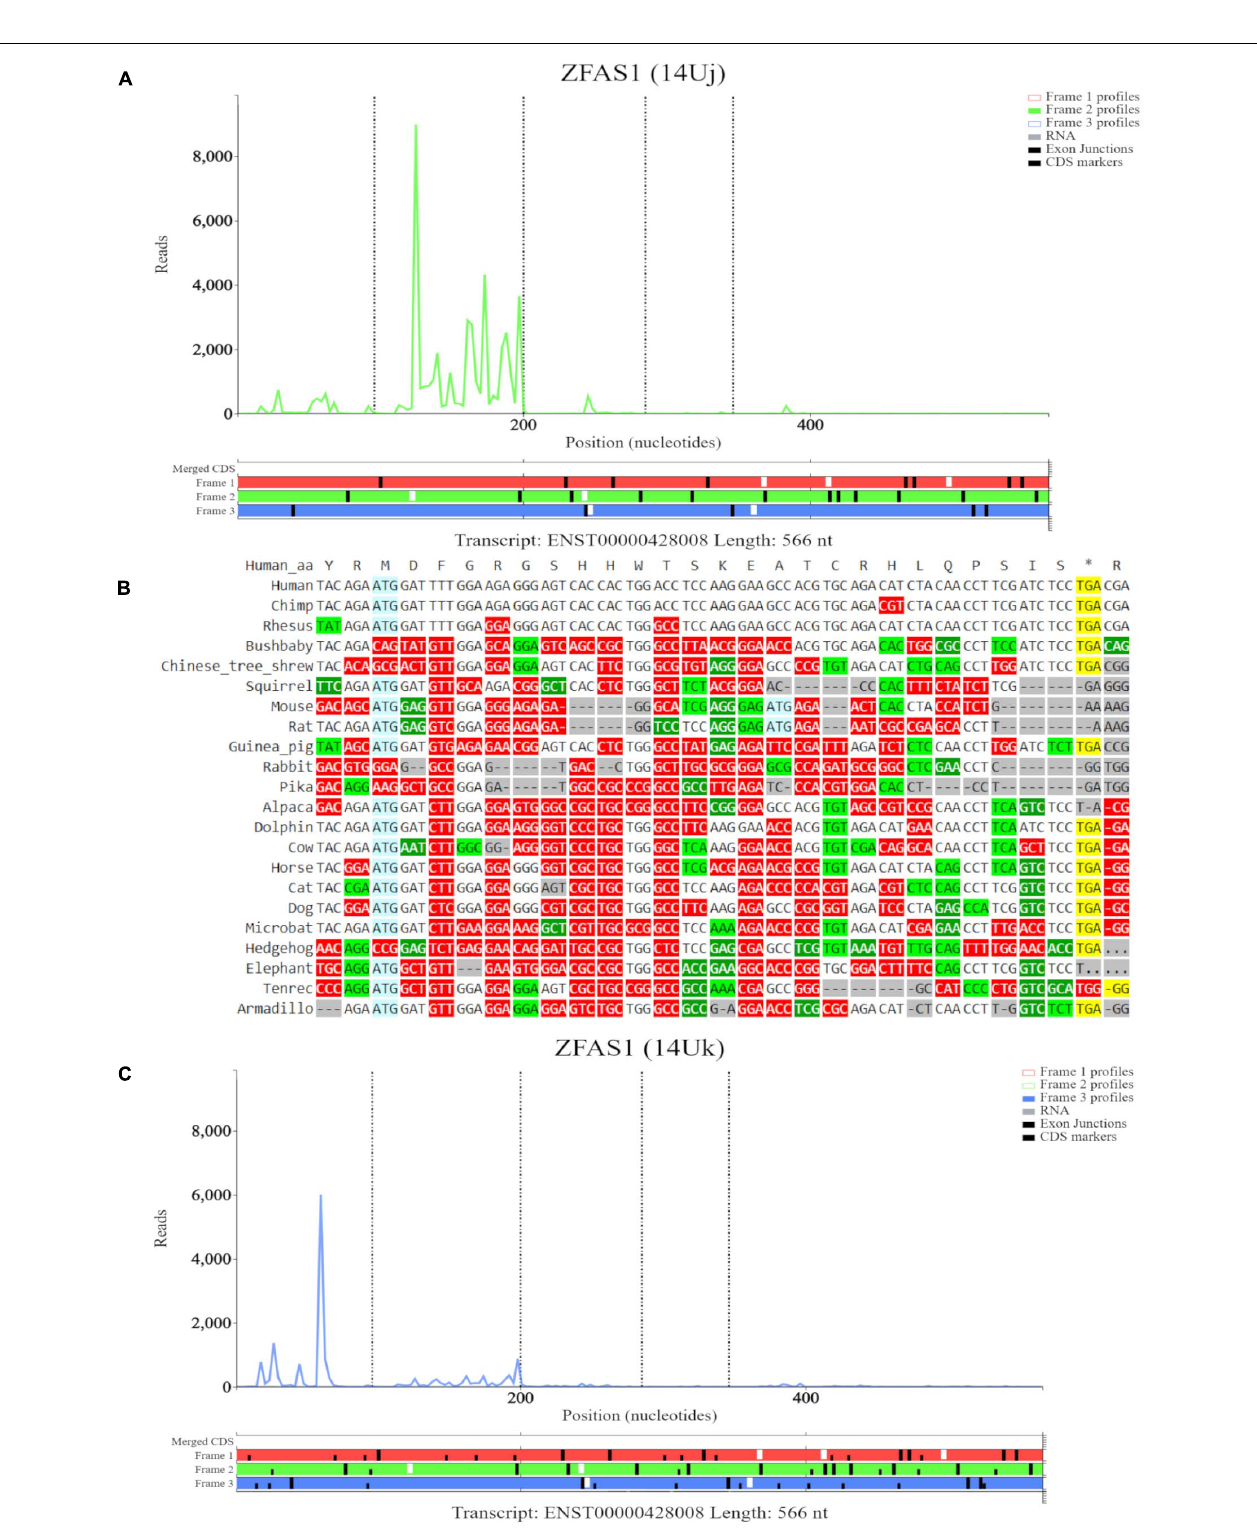
FIGURE 7 | Visualization of ZFAS1 in Trips-Viz and CodAlignView. (A) Visualization of transcript ENST00000428008 without RNA-seq data enabled and only reading frame 2 enabled. (B) CodAlignView for the ORF on ZFAS1 showing a high ratio of radical non-synonymous codon substitutions. (C) Visualization of transcript ENST00000428008 without RNA-seq data enabled and only reading frame 3 enabled. Alternative start sequences of CTG and GTG were enabled and are represented by the black dashes.